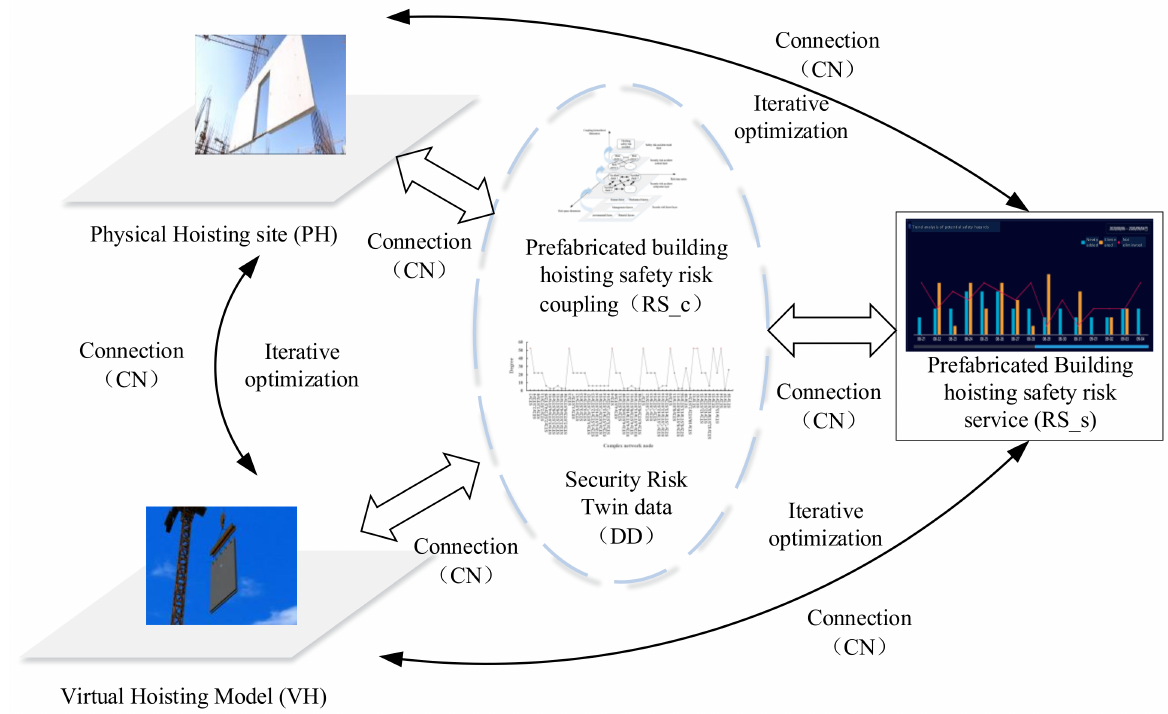
Figure 2. DT-based safety risk coupling model of prefabricated building